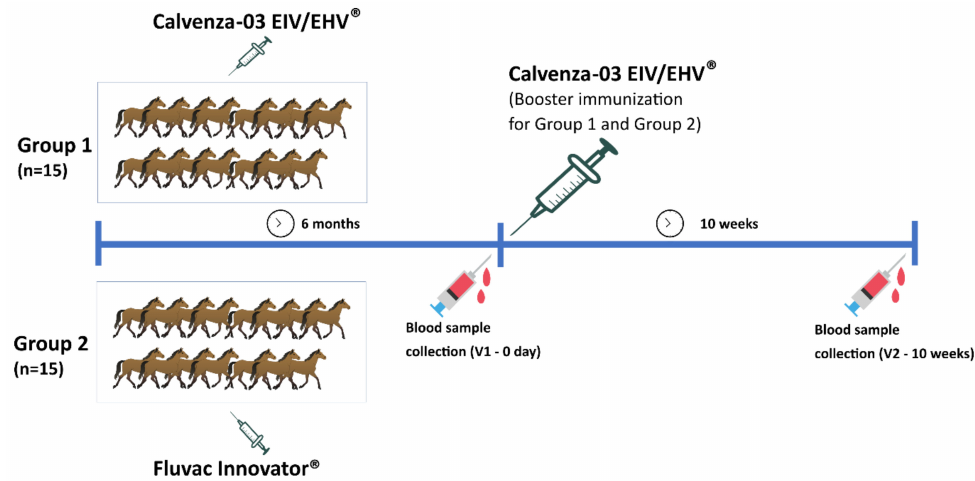
Figure 1. Vaccination and sampling